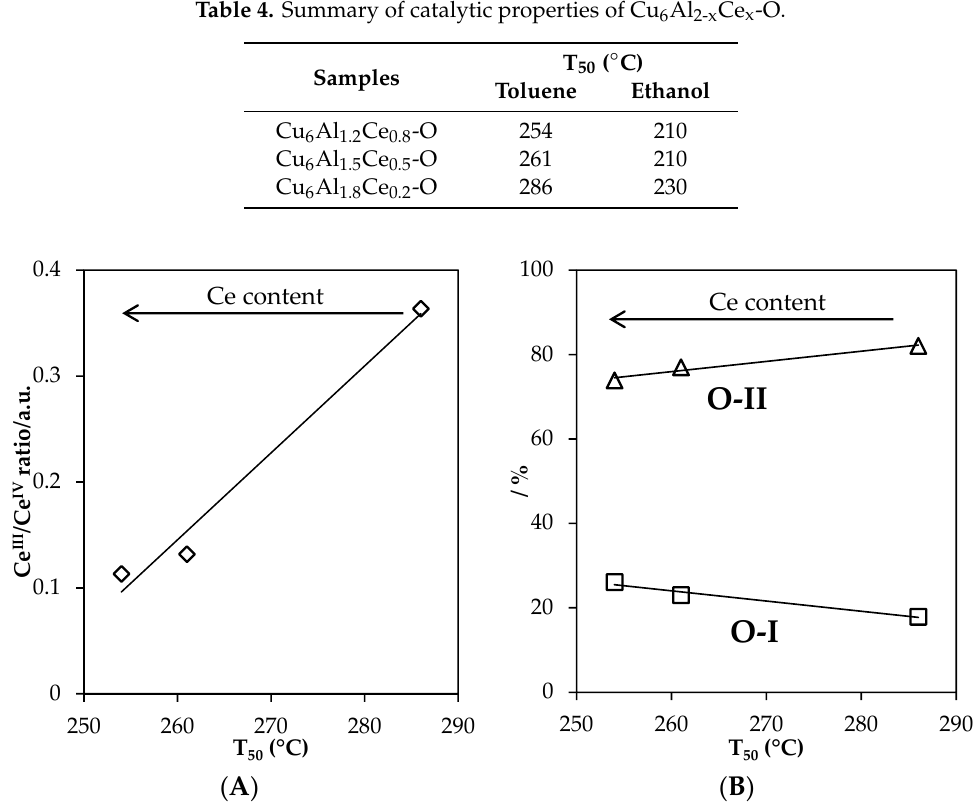
Figure 10. Evolution of XPS data (A: Ce IV /Ce III ratio, B: %O-I and %O-II) with T 50 for toluene oxidation reaction. Catalysts 2020 , 10 , x FOR PEER REVIEW